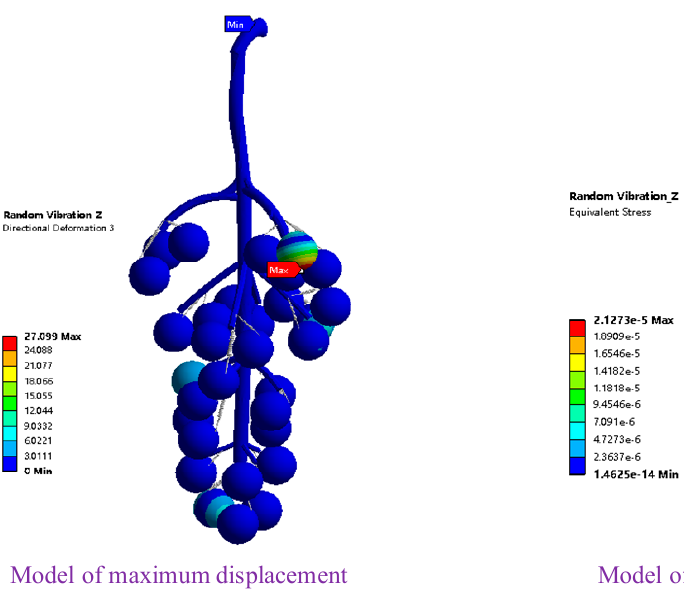
Figure 9. Vibration response in the Z direction.